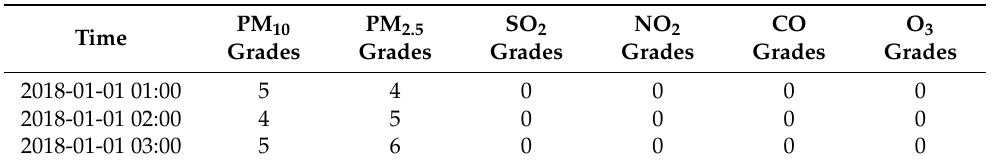
Table 3. An example of air pollutant grades at the Central Square Station of Xi’an Xin Cheng district